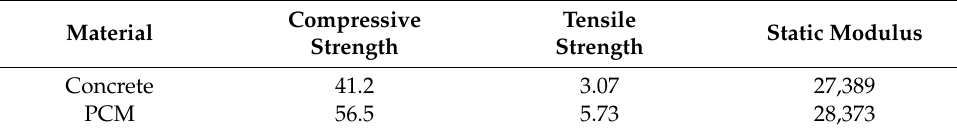
Table 1. Average value of the material property (Unit: MPa).